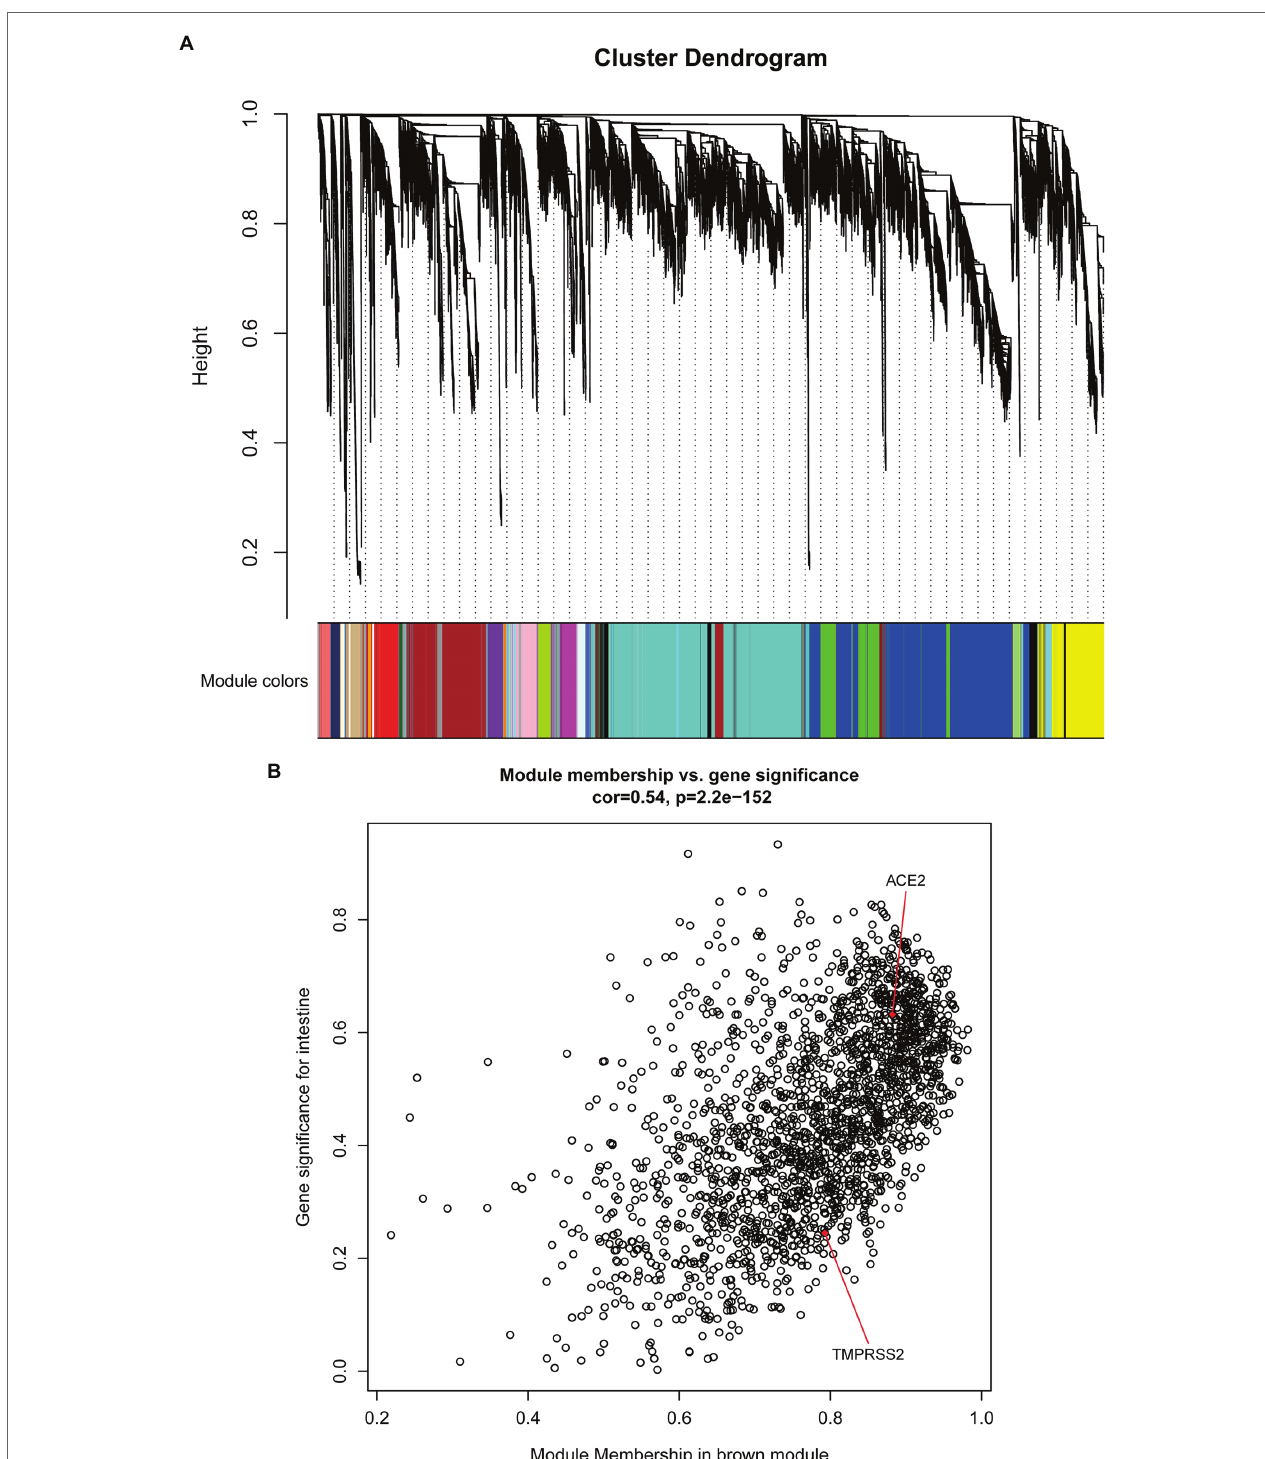
FIGURE 6 | WGCNA analysis of organs of the fetus. (A) Gene dendrogram obtained by average linkage hierarchical clustering. The color row underneath the dendrogram shows the module assignment determined by the Dynamic Tree Cut. (B) The scatterplot of Gene Significance (GS) for intestine vs. Module Membership (MM) in the brown module. GS is (the absolute value of) the correlation between the gene and the trait, and for each module, MM is the correlation of the module eigengene and the gene expression profile. The red points are ACE2 or TMPRSS2 and have a highly significant correlation between GS and MM in this